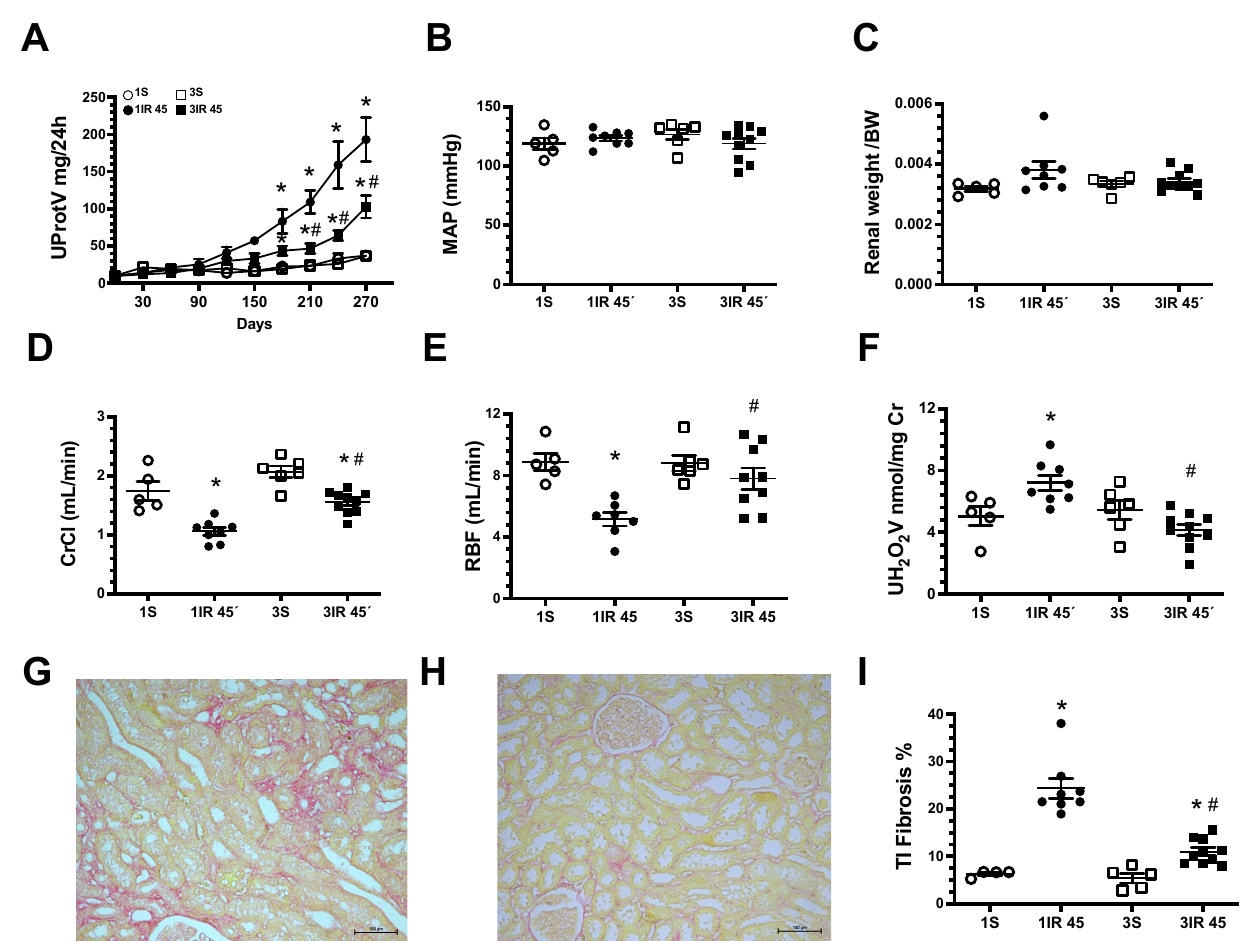
Figure 3. Repeated episodes of IR 45 min delayed the progression to chronic kidney disease. ( A ) Uri- nary protein excretion measured every 30 days during nine months of the follow-up. At the end, the rats were studied: ( B ) mean arterial pressure (MAP), ( C ) renal weight/body weight ratio, ( D ) crea- tinine clearance (Ccr), ( E ) renal blood flow (RBF), and ( F ) urinary H 2 O 2 excretion. Representative microphotographs of Sirus red stained slices from a kidney rat underwent ( G ) one IR episode or ( H ) three IR episodes (magnification 150 × ), and in ( I ) tubule-interstitial fibrosis percentage. The sham group underwent one surgery (1S) is represented in white circles, rats underwent one IR episode for 45 min (1IR) in black circles, sham group subjected to three false surgeries, one each 10 days (3S) is in white squares, and three episodes of 45 min, one each 10 days (3IR) is in black squares. * p < 0.05 vs. both 1S or 3S; # p < 0.05 vs. 1IR